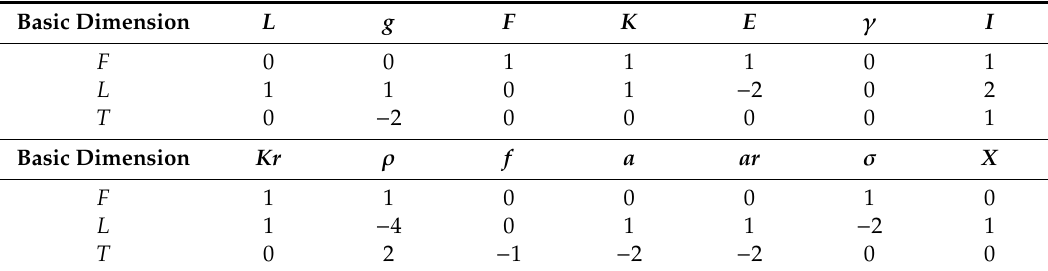
Table 1. Basic dimension of related